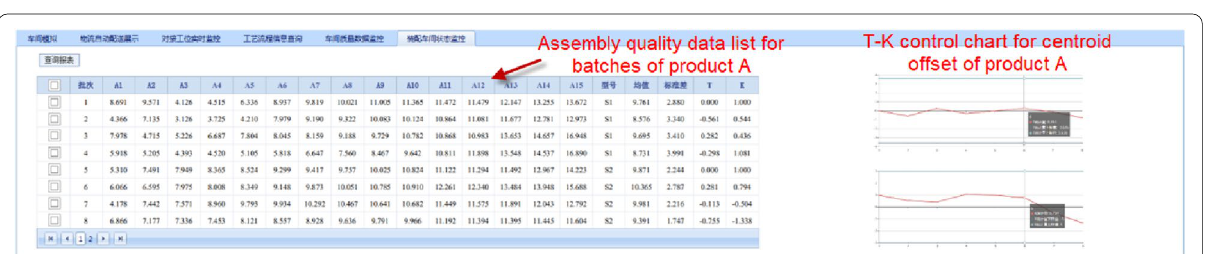
Figure 14 Interface for monitoring assembly shop-floor